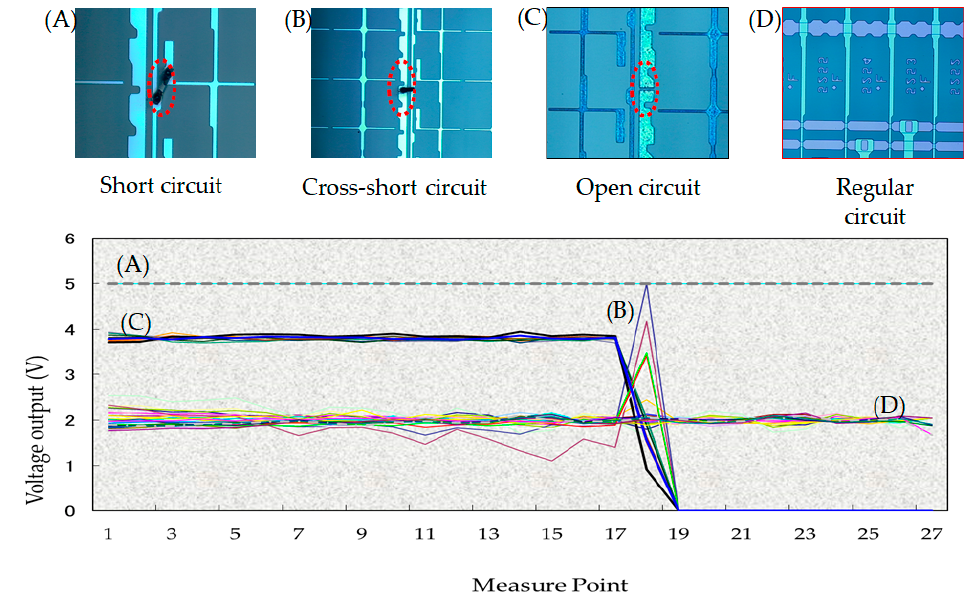
Figure 9. The voltage profile of the various conditions: ( A ) the short defect voltage; ( B ) the cross short defect voltage; ( C ) the open defect voltage; and ( D ) the regular circuit .